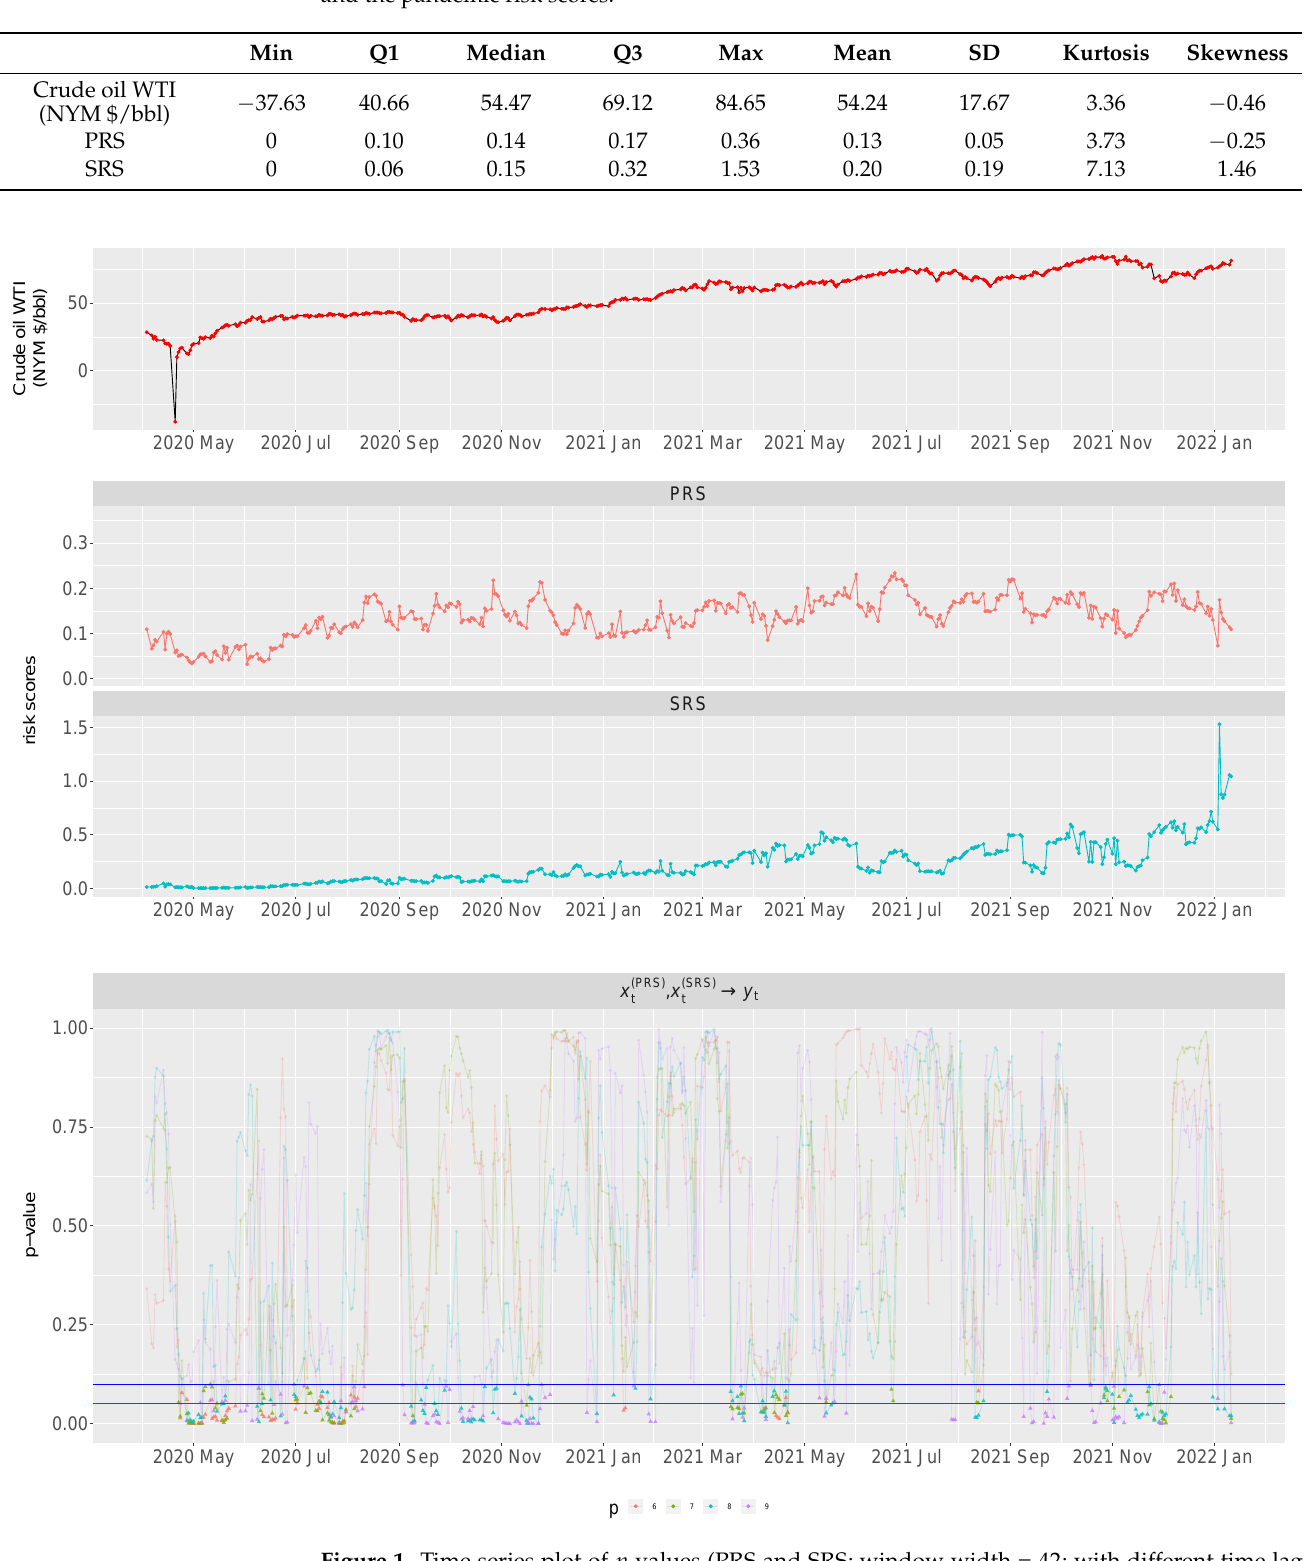
Figure 1. Time series plot of p -values (PRS and SRS; window width = 42; with different time lag p = { 6,7, . . . ,9 }